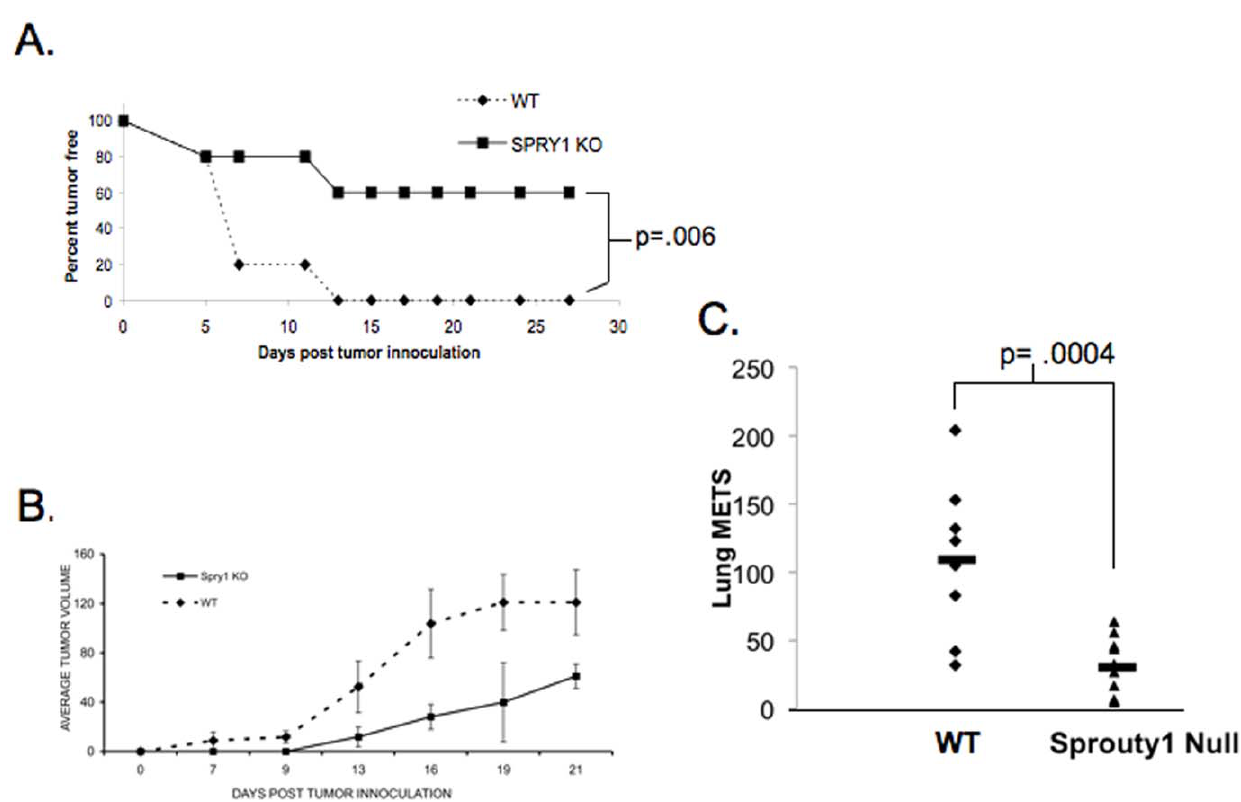
Figure 8. Spry1 null mice have enhanced clearance of EL-4 tumor cells. Wild type and Spry1 null mice were subcutaneously injected with EL- 4 tumor cells. Mice were monitored for ( A ) tumor free survival and ( B ) tumor volume. All experiments were performed at least three times. ( C ) Wt and Spry1 null T cell mice were injected IV with 250,000 B16 melanoma cells, 14 days later mice were sacrificed and lung tumors were counted. P values indicate statistical significance by student t-test. All experiments were performed at least three times. Data are representative of 10 mice per